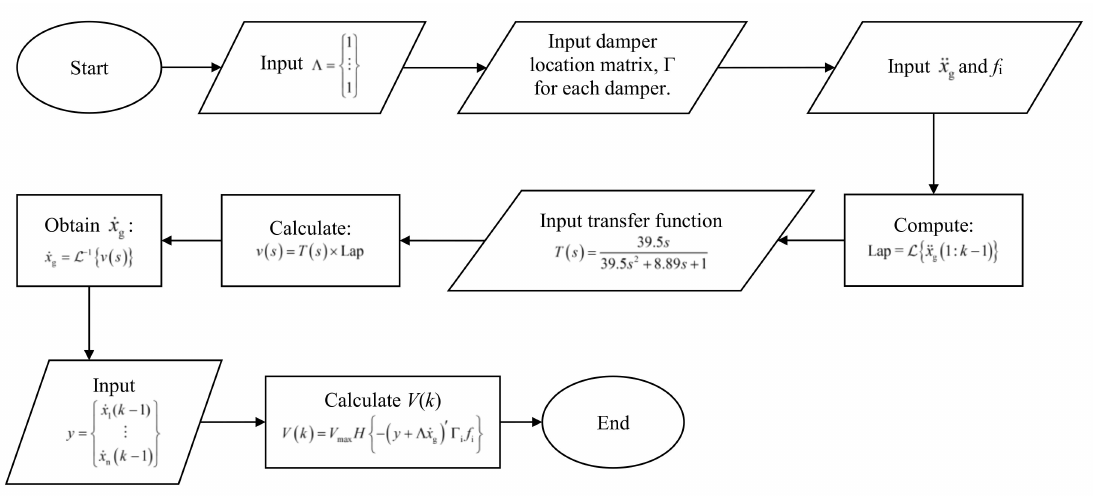
Figure 3. Flowchart for simulating decentralized bang-bang control